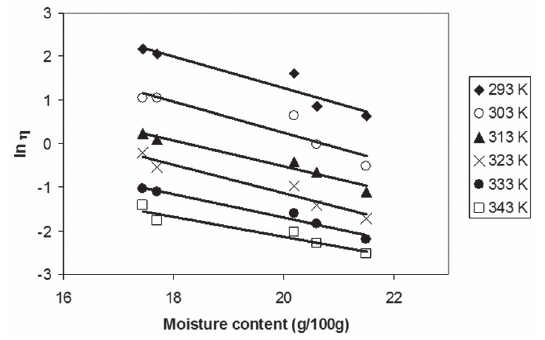
Figure 6 - Effect of moisture content on honey viscosity at various temperatures.